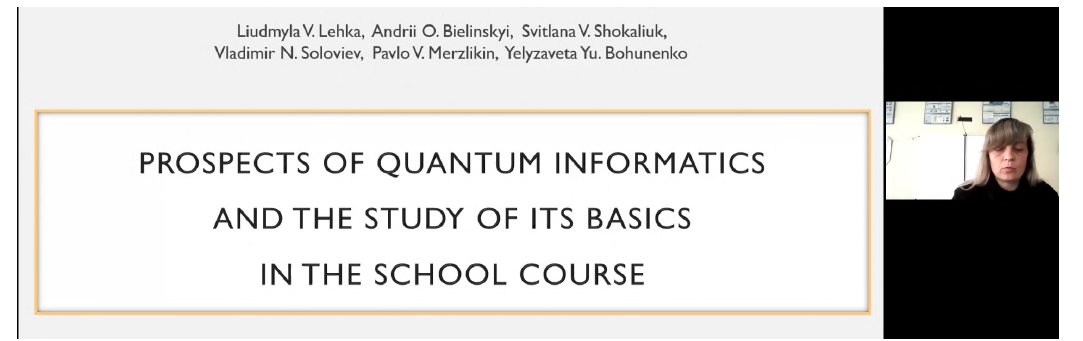
Figure 35: Presentation of paper